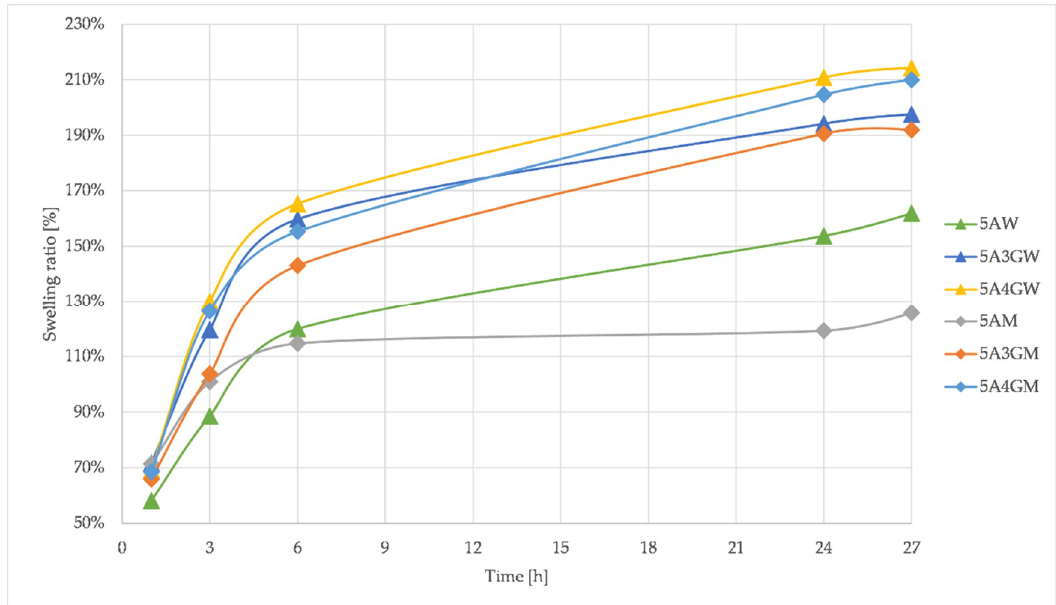
Figure 6. Swelling ratio for samples dissolved in water (W) and full culture medium (M) with different content of gelatine measured after 1 h, 3 h, 6 h, 24 h, and 27 h.